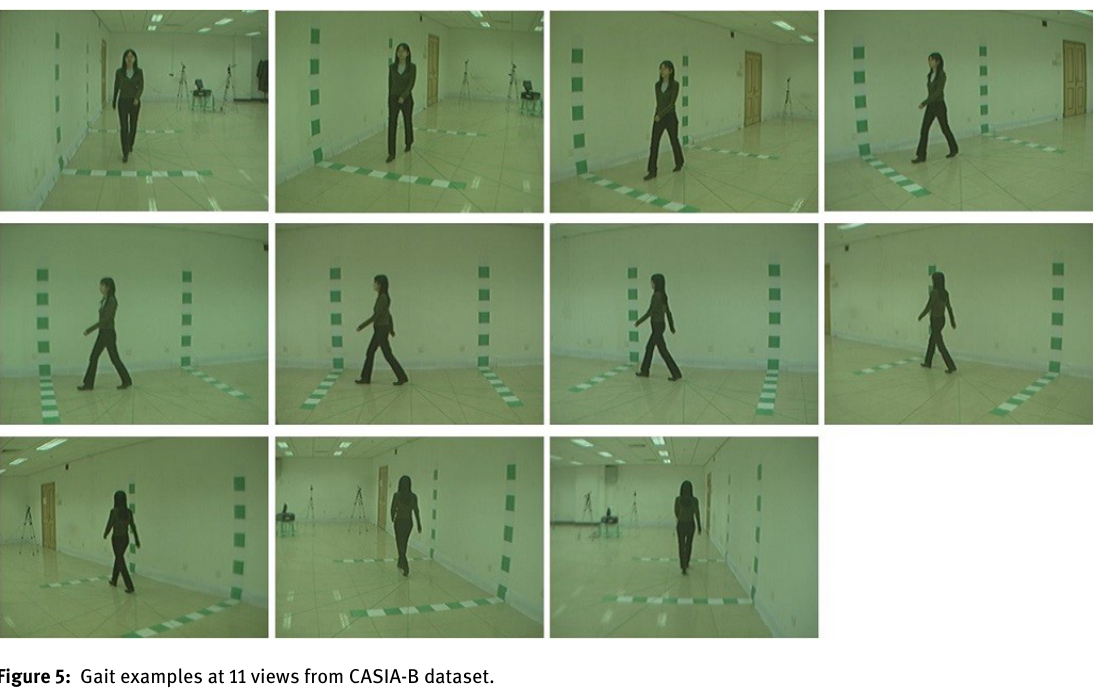
Figure 5: Gait examples at 11 views from CASIA-B dataset.